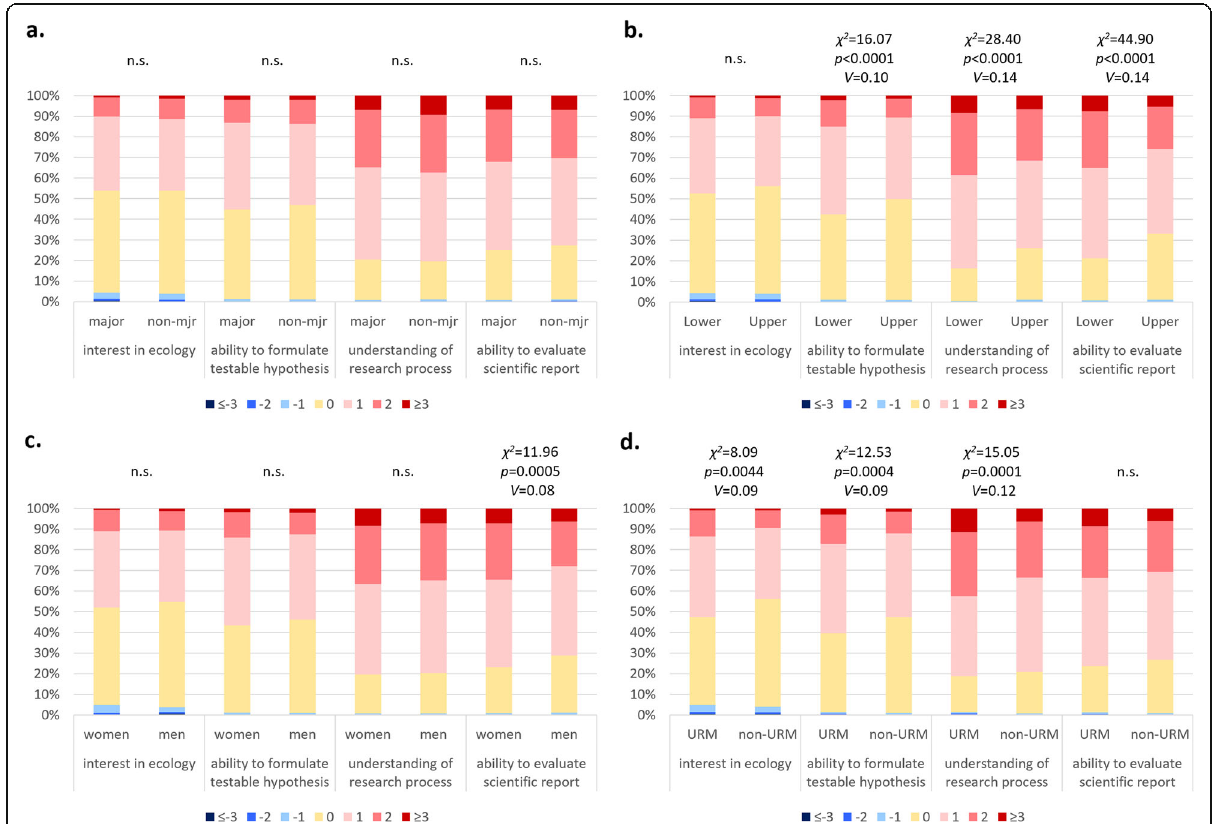
Fig. 4 Comparisons of self-reported learning gains for pairs of student groups. Comparisons of self-reported gains, post-IP (inquiry project) score minus pre-IP score, between a majors and nonmajors ( n = 1777 and 937), b lower- and upper-division students ( n = 1052 and 1062), c women and men ( n = 1361 and 1353), and d under-represented minorities (URM) and other ethnicities ( n = 630 and 2084). The χ 2 statistic and p value for Cochran-Mantel-Haenszel test and the effect size (Cramer ’ s V ) are shown above each group with significant difference ( df =